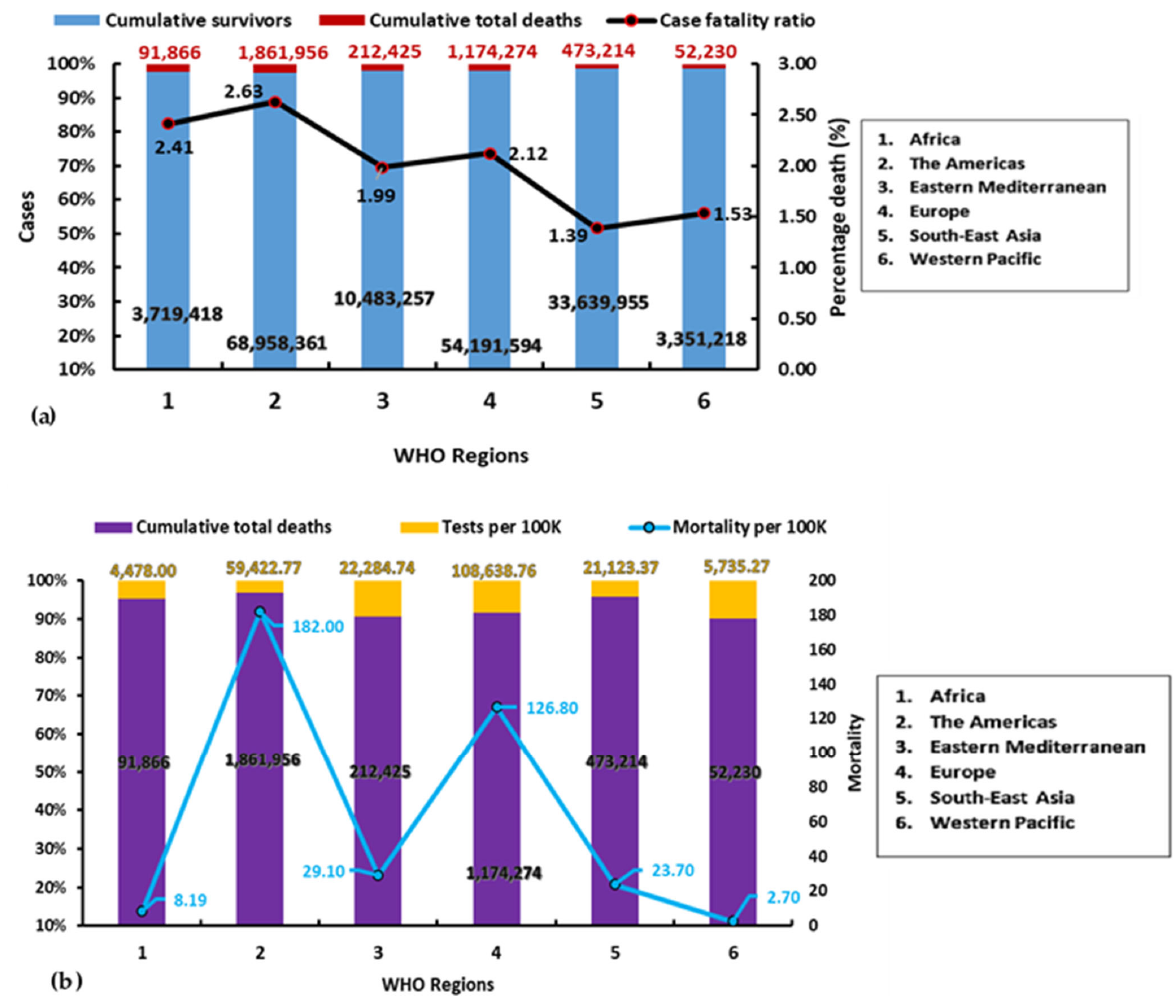
Figure 1. ( a ) World-wide COVID-19 cases and deaths according to regions, based on WHO data of 21 June 2021. ( b ) COVID-19 deaths, mortality per 100,000 persons and test rate per 100,000 persons according to regions, based on data up to 21 June 2021.